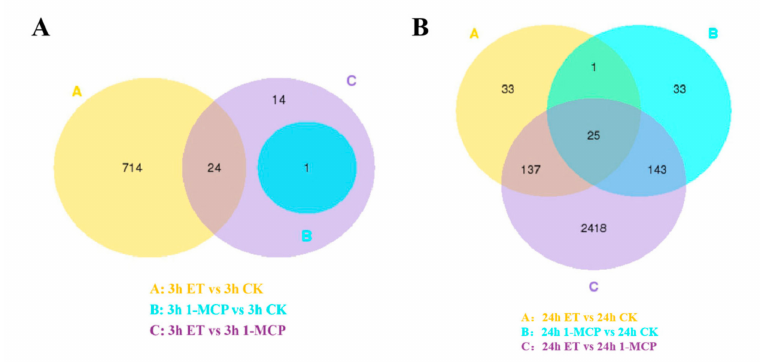
Figure 2. Venn diagrams of differentially expressed genes. ( A ) Numbers of differentially expressed genes after 3 h of ethylene or 1-MCP treatment. ( B ) Numbers of differentially expressed genes after 24 h of ethylene or 1-MCP treatment. 1-MCP,